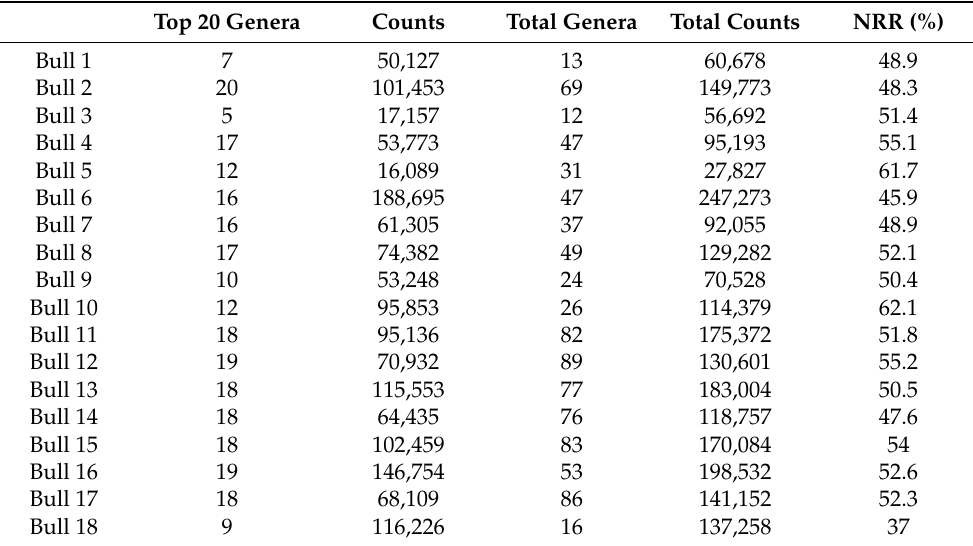
Top 20 genera: 20 most frequently seen genera in all samples; counts: read counts of genera per bull present in the top 20; total genera: number of identified genera per bull; total counts: read counts of genera per bull of all genera per bull; NRR: non-return